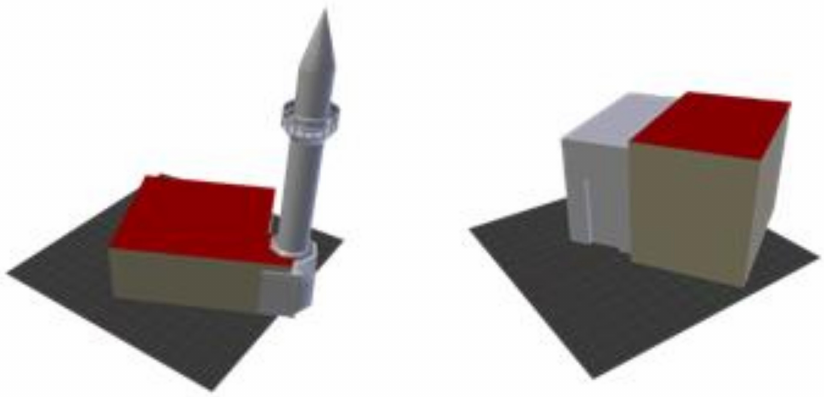
Figure 5. The 3D mesh of the 3D models in scale with the existing